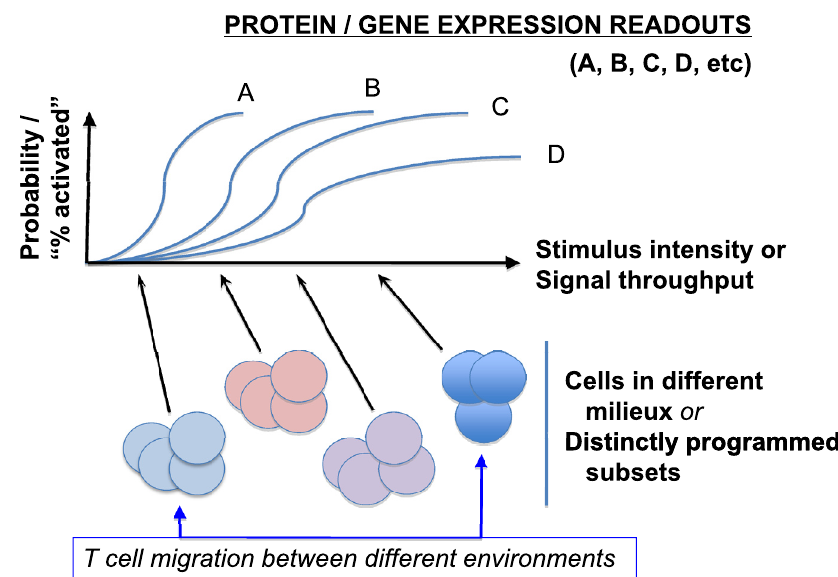
Figure 2. Challenges in extrapolating complete (or almost complete) and permanent loss-of-function results to sensors poised with different dose-response curves and threshold settings in biological ranges. As highlighted by evolving single-cell stimulus-response research 34,35 , a given stimulus will often yield a probability of evoked response well below 1, and this stimulus-probability curve will vary within a series of gene expression or downstream signal intensities pertinent to T-cell differentiation or function. Accordingly, as cell conditions or pre-existing programs vary or as different extents of impairment to a given signal relay are imposed, the responses will exhibit variegation among cells in a population. Similar principles are postulated almost certainly to apply to the time element (e.g. how long does it take for a condition to change histone post-translational modifications or epigenetic modification of DNA or to change the level of expression of a target gene?). As noted in Figure 4, local conditions vary even within a single tumor mass (setting aside known differences between metastatic and primary